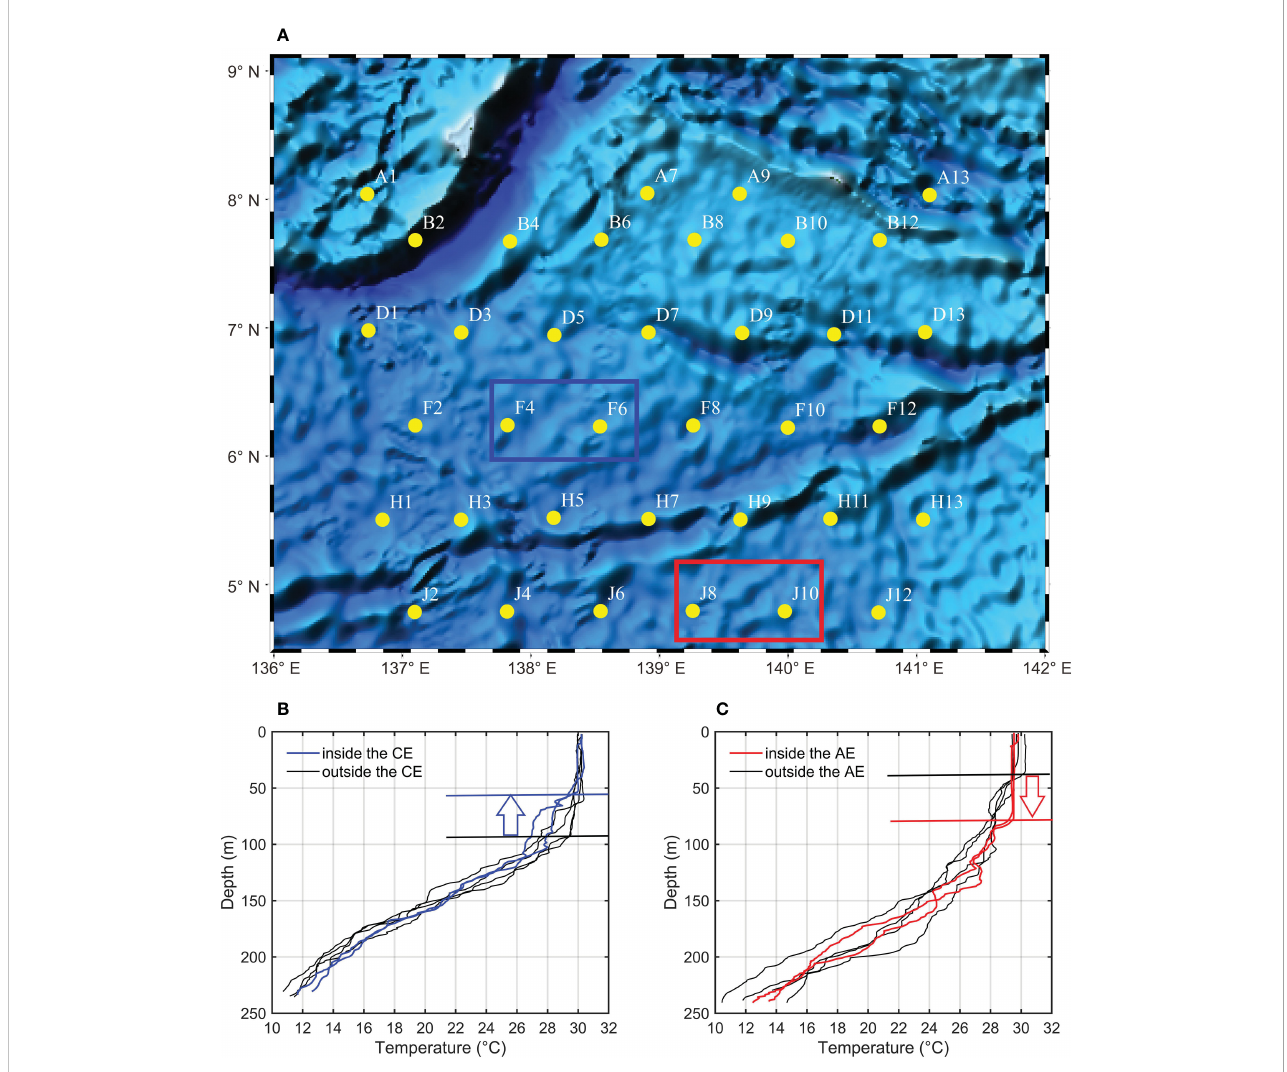
FIGURE 9 The temperature pro fi les of the observational stations, (A) is station distribution map, in which the blue and red boxes represent location of stations within the eddy ranges, respectively; (B) temperature pro fi les of stations inside two different CEs and other stations at transect F with the same latitude; (C) temperature pro fi les of stations inside a single AE and other stations at transect J with the same